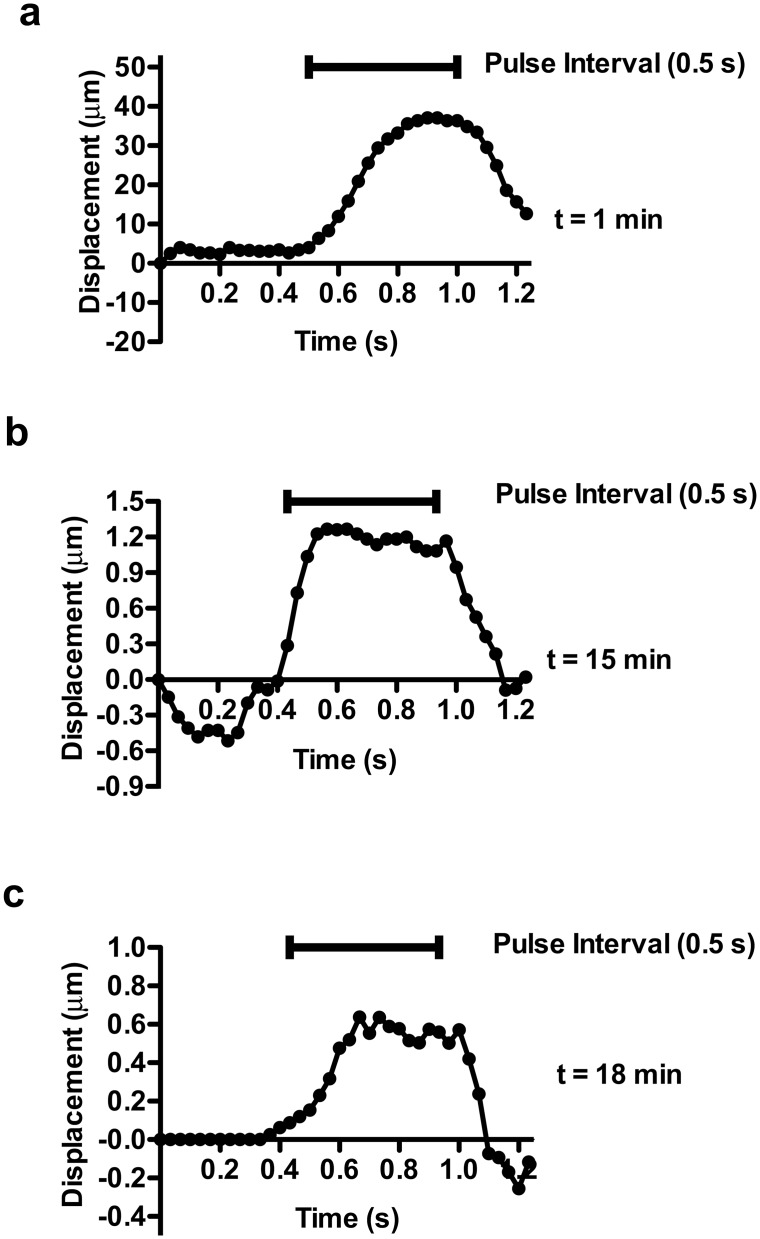
Characteristic bead displacement due to applied ARF at 7.5 kHz in clotting platelet poor plasma.(a) At t = 1 min the bead displaced 40 μm during a 0.5 s pulse interval and recoiled after the pulse stopped. (b) At t = 15 min the bead displaced 0.9 μm during the pulse interval and recoiled after the pulse stopped. (c) At t = 18 min the bead displaced 0.5 μm during the pulse interval and recoiled after the pulse stopped. Optical noise was reduced by smoothing with a 3 data point moving average filter.